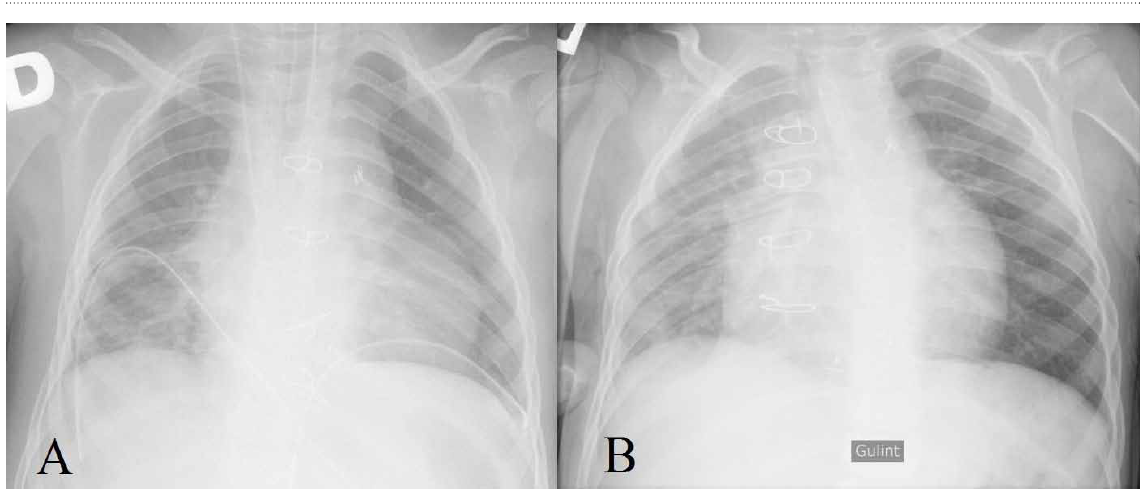
Figure 2. Comparison of chest radiograms: 12 hours before PediVAS pump implementation (A) and after PediVAS pump removal (B). The significant reduction of the size of the heart can be observed in Figure